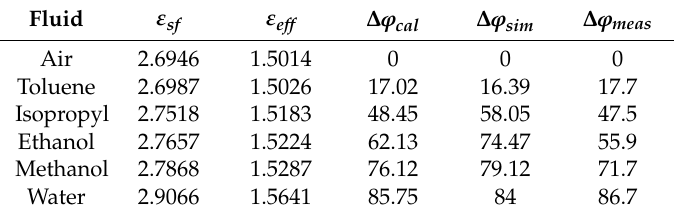
Table 2. Calculated, simulated and measured phase shifts for different fluids in the microchannel. Fluid ε sf ε eff ∆ ϕ